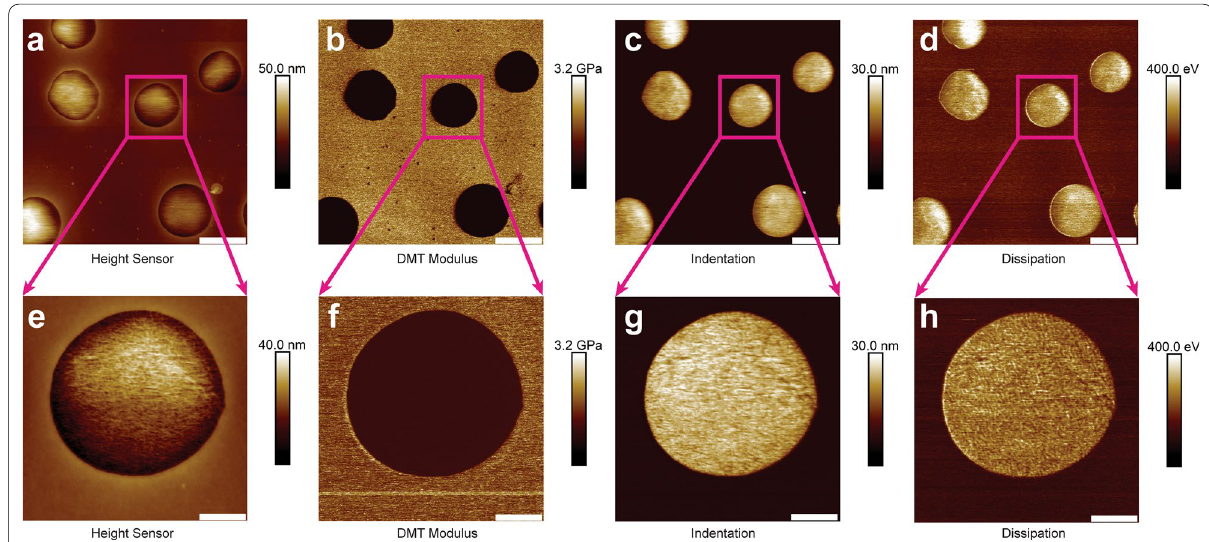
Fig. 2 Representative PFQNM nanomechanical mapping (5 µm 5 µm) of PS/LDPE blend sample at 2 kHz. Panels a – d are height sensor image, × DMT modulus channel, indentation channel, and energy dissipation channel. For images a – d , the scale bars represent 1 µm. On the completion of the survey scan, the AFM is guided to physically zoom in on the LDPE region and take a high-resolution small size (1.3 µm 1.3 µm) scan. The × corresponding image channels are displayed in panels e–h . The scale bar represents 260 nm for panels e –